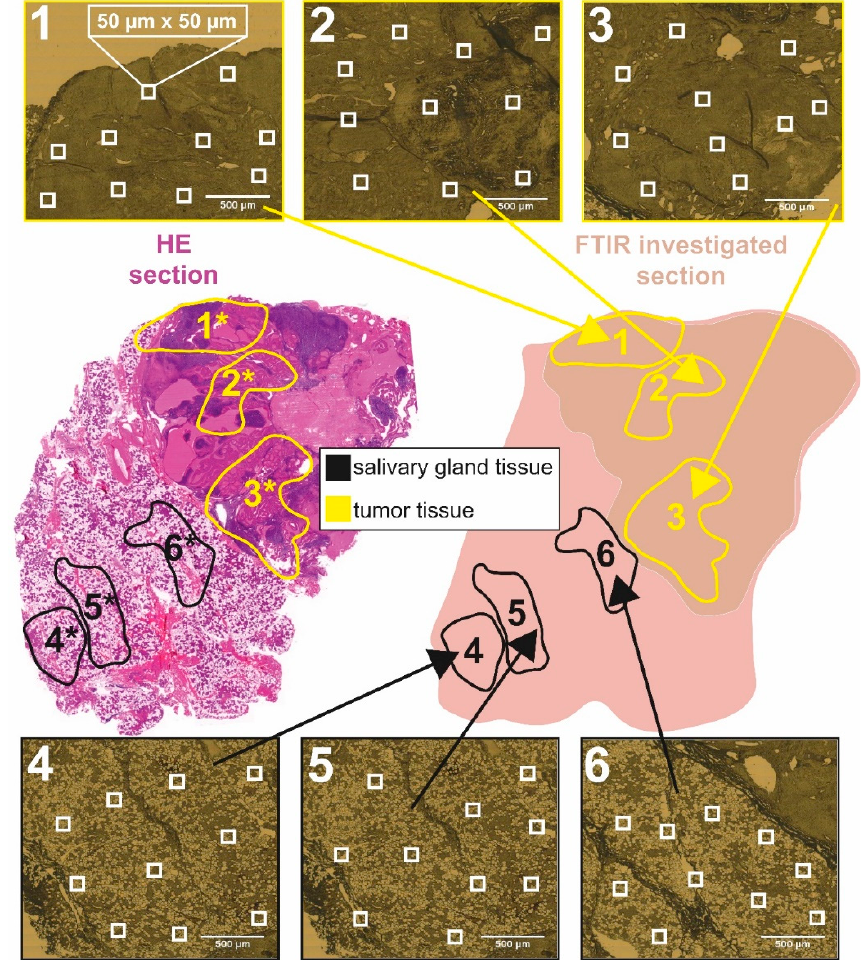
Figure 2. Identification of different tissue measurement regions for FTIR microspectroscopy. For each preservation method, standardized HE-stained sections were used to assign various tissue regions of interest, defined as regions 1 *– 6 * (HE-section left). Identical salivary gland and tumor regions were defined in consecutive, non-stained tissue sections, schematically illustrated in region 1 – 6 (schematic section right). These predefined regions were additionally captured by the FTIR video image camera (images 1 – 6 on top and bottom). Within the video images, 10 single FTIR spectra were randomly acquired in a measuring area of 50 µm × 50 µm (white squares).